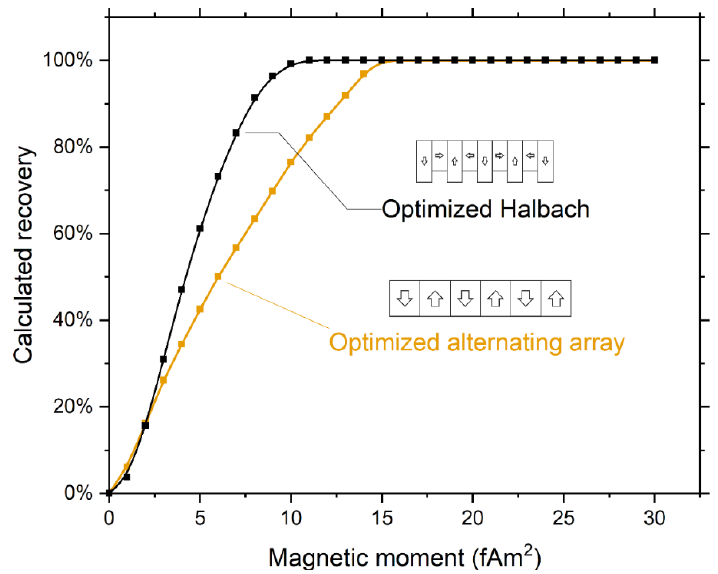
Figure 8. Comparison of recovery dependence on magnetic moment between the optimized alternating array (2.0 mm width) and the optimized Halbach array (1.0 mm width) showing a decrease in magnetic moment needed to achieve 100% recovery. For very low magnetic moments, where only the cells close to the surface are captured, the alternating array outperforms the Halbach array due to its higher gradient close to the surface.